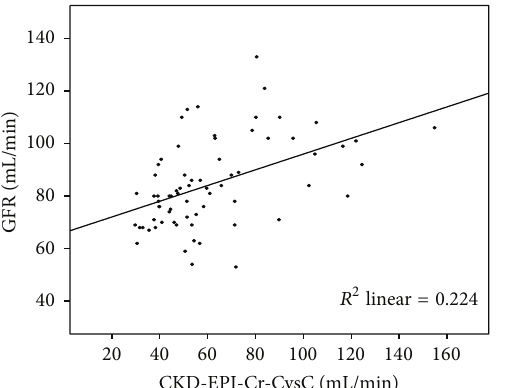
Figure 1: Scatter plots of the isotopic glomerular filtration rate (GFR) versus 1/creatinine, creatinine clearance, 1/cystatin C, Cockcroft-Gault formula, MDRD equations with 4 and 6 variables, CKD-EPI-Cr, CKD-EPI-CysC, and CKD-EPI-Cr-CysC.